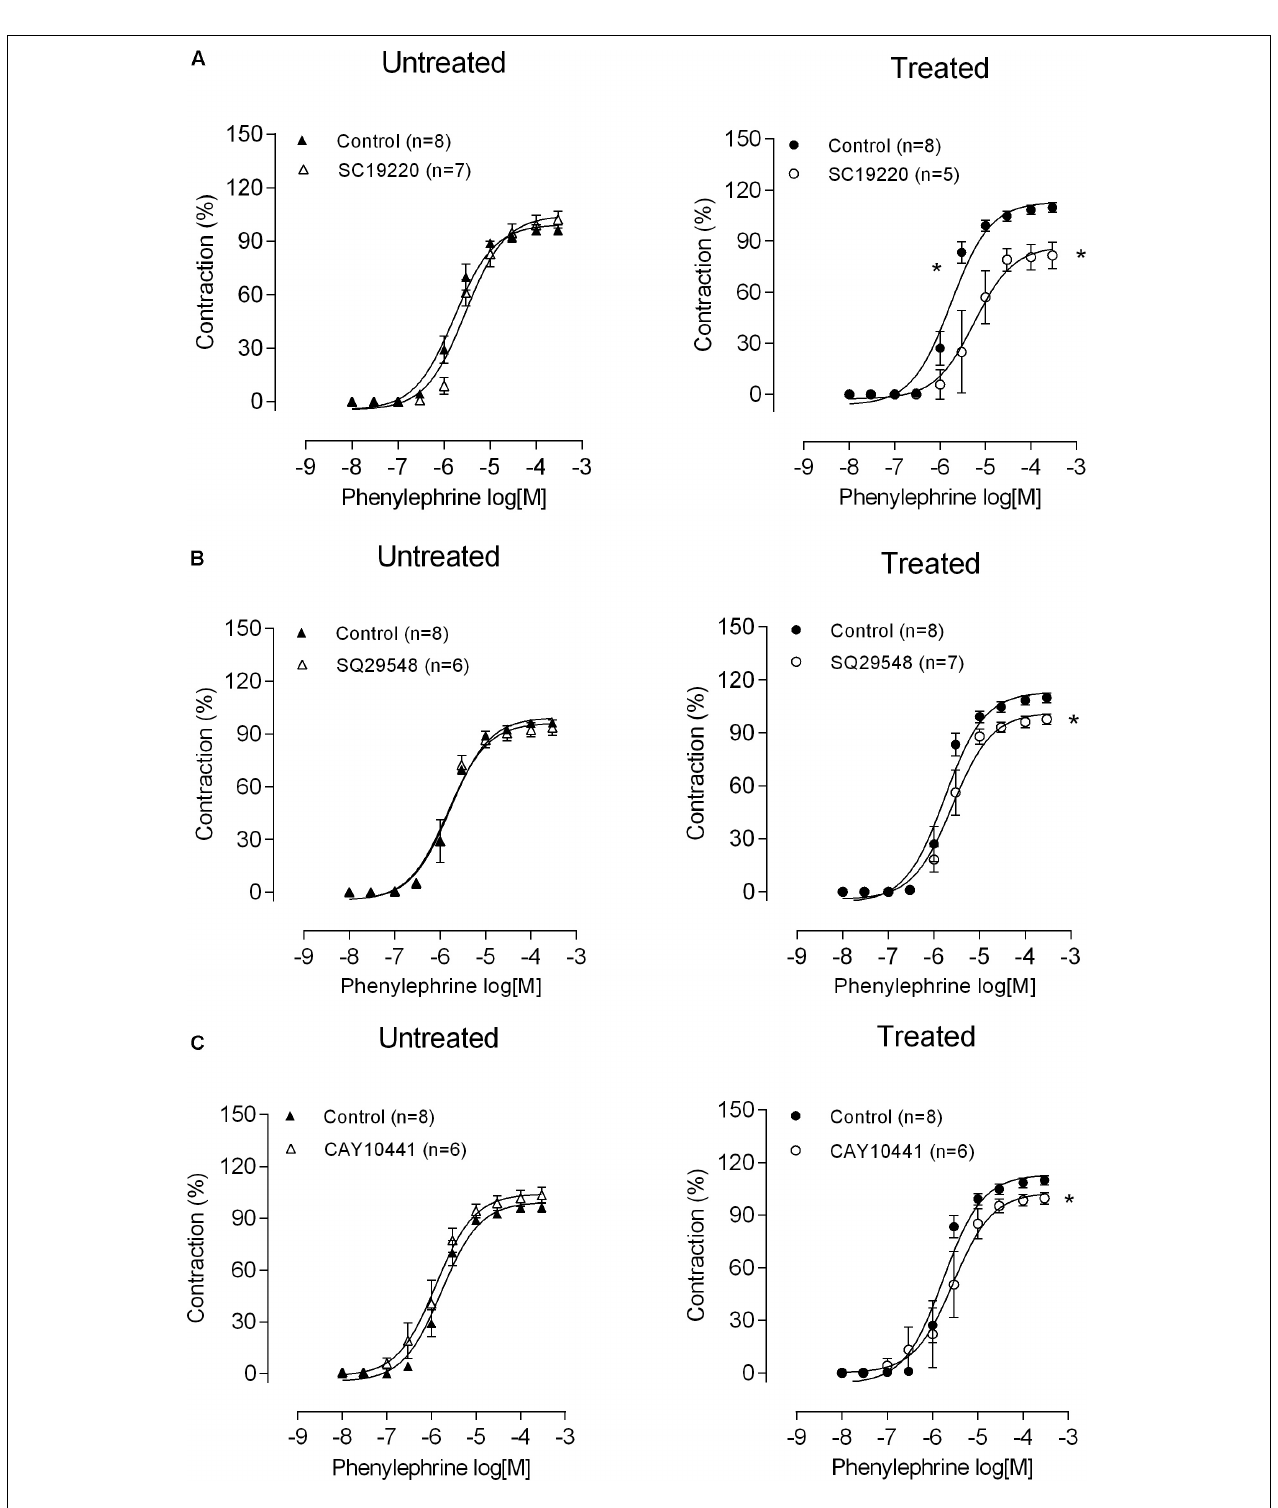
FIGURE 5 | Role of prostanoidsin altered phenylephrine responses after lead treatment. The effect of (A) the EP1 antagonist SC19220, (B) the TXA2 receptor antagonist SQ29548, and (C) the IP receptor antagonist CAY10441 on the concentration-response curve to phenylephrine in mesenteric rings from untreated and treated rats. * P < 0.05 versus control using two-way ANOVA and Bonferroni post hoc test. Data are expressed as the mean ± SEM. n denotes the number of animals used and is indicated in parentheses.